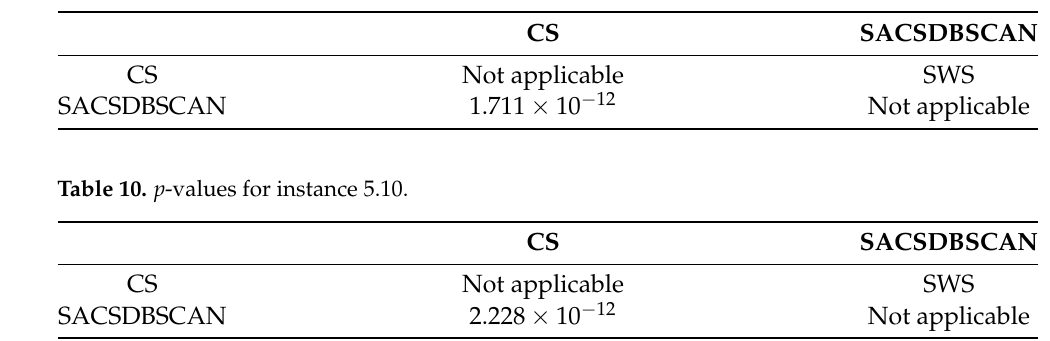
Table 9. p -values for instance 4.10.